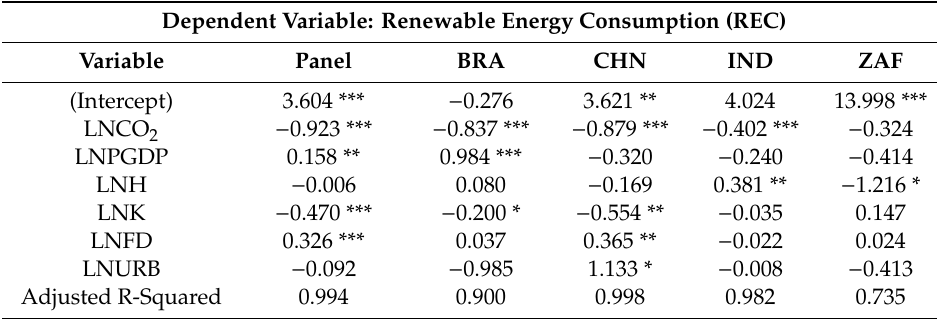
LNURB Adjusted R-Squared